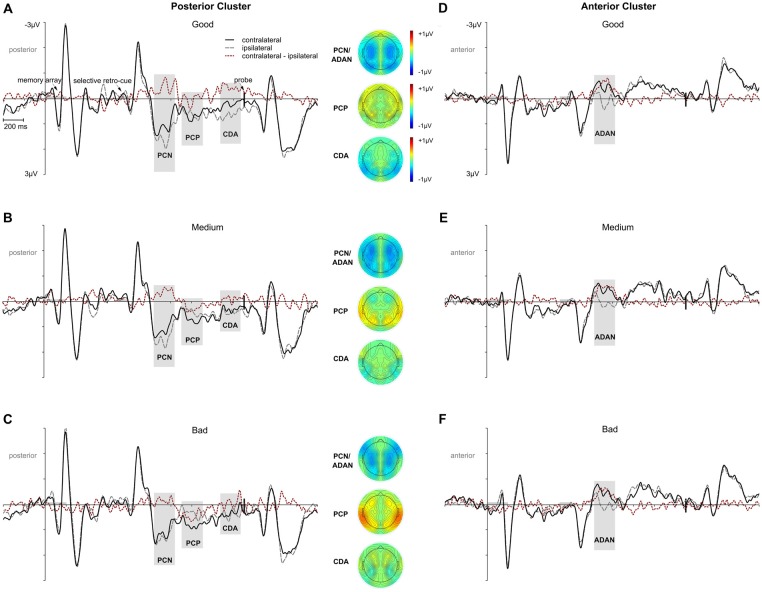
ERP effects as a function of performance for the selective retro-cue condition. Presentation times of the memory array and the retro-cue are highlighted in gray. The onset of the probe array is indexed by the vertical black line. Panels (A–C) depict PCN, PCP and CDA effects for the posterior cluster separately for trials with good, medium, or bad performance. The ADAN effect at anterior sites as a function of performance is shown in (D–F). Separate topographies are given for the 200 ms intervals centered on the mean of the resulting individual participants’ FAL50. The red dotted lines reflect the contralateral minus ipsilateral difference waves.